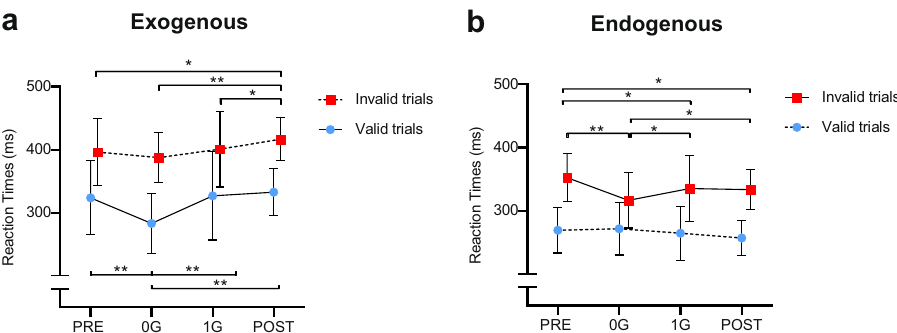
Fig. 2 Mean reaction times (RTs) and SD ( n = 5) for valid and invalid trials for the two tasks across gravity conditions. a Exogenous task: valid trials were faster in 0 g compared to 1 g conditions; invalid trials were slower in POST compared to all other conditions. b Endogenous task: invalid trials were faster in 0 g compared to 1 g conditions; invalid trials were slower in PRE compared to 1 G and POST. There were no signi fi cant differences for valid trials. Newman-Keuls post-hoc analyses, *P < 0.05 and ** P < 0.01. PRE = 1 g before fl ight, 0 G = 0 g on the fl ight, 1 G = 1 g on the fl ight, POST = 1 g after the fl